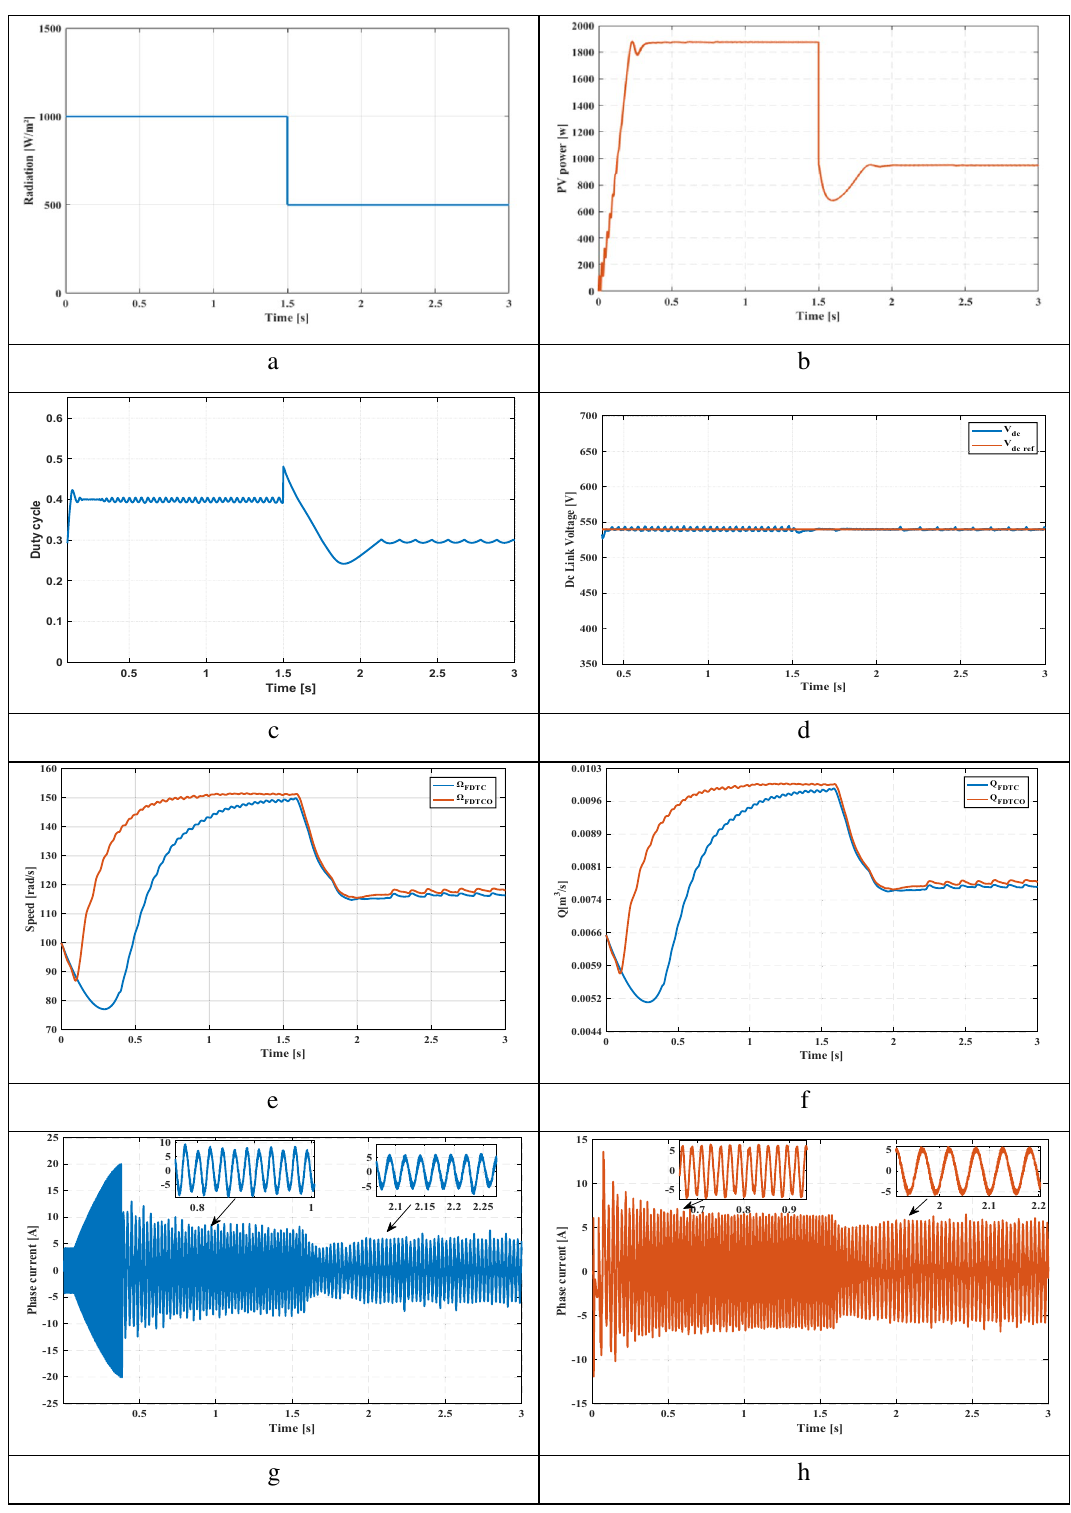
Figure 9. ( a ) Solar radiation ( b ) Extracted power ( c ) Duty cycle ( d ) DC link voltage ( e ) Rotor speed ( f ) water Flow ( g ) Stator phase current of FDTC ( h ) Stator phase current of FDTCO ( i ) Flux response using FLC ( j ) Flux response using FDTCO ( k ) Stator flux trajectory using FDTC ( l ) Stator flux trajectory using